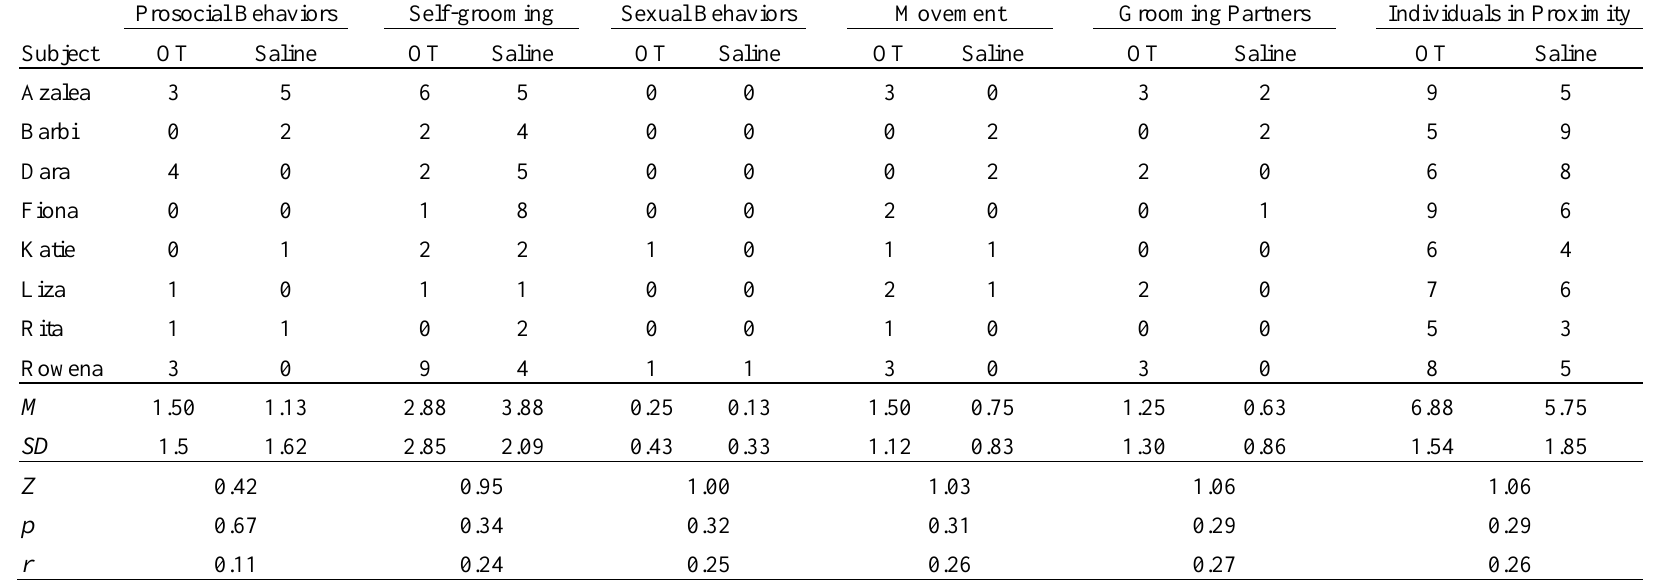
Frequencies of Behaviors Prosocial